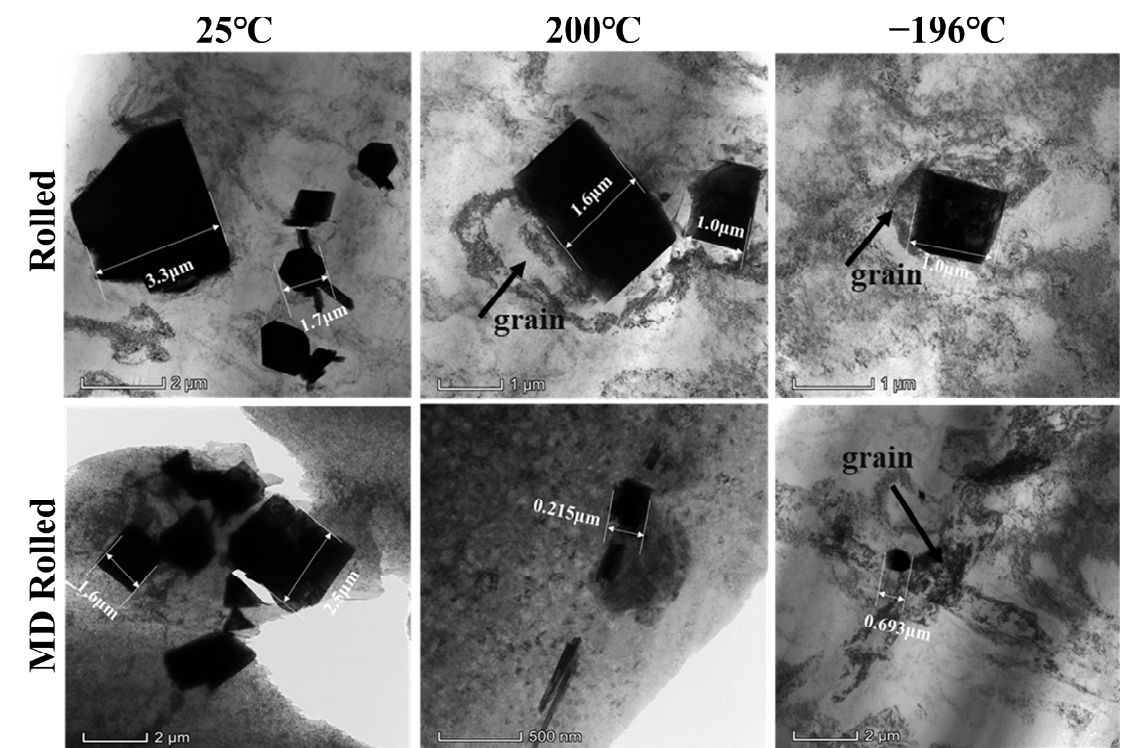
Figure 4. TEM images of the fragmentized primary second phase under various circumstances.